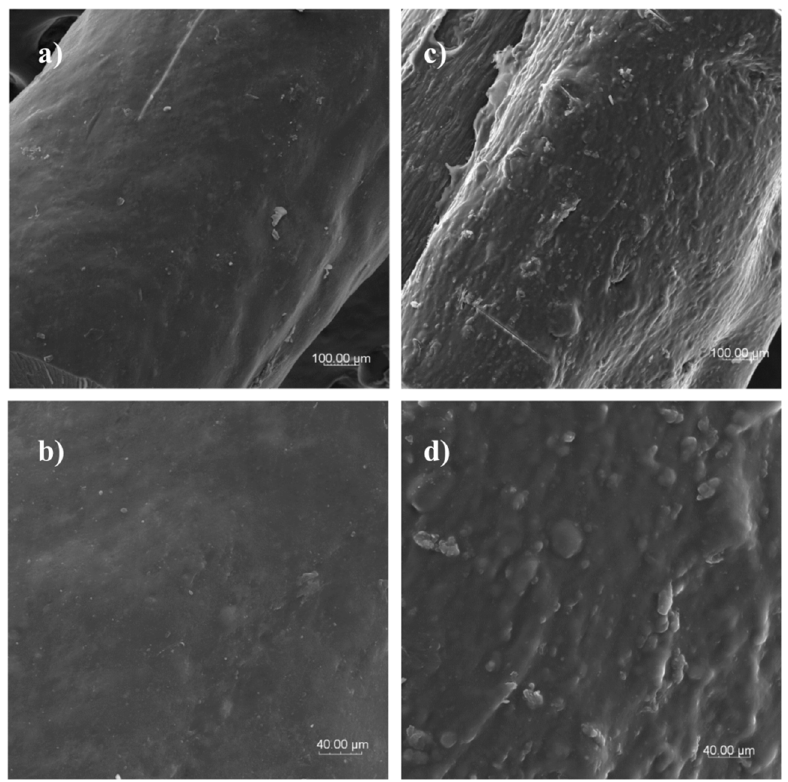
Figure 4. Surface of dry ( a , b ) and hydrated ( c , d ) rice-buckwheat pasta at di ff erent magnifications (200 × for a , c ; 600 × for b , d ).